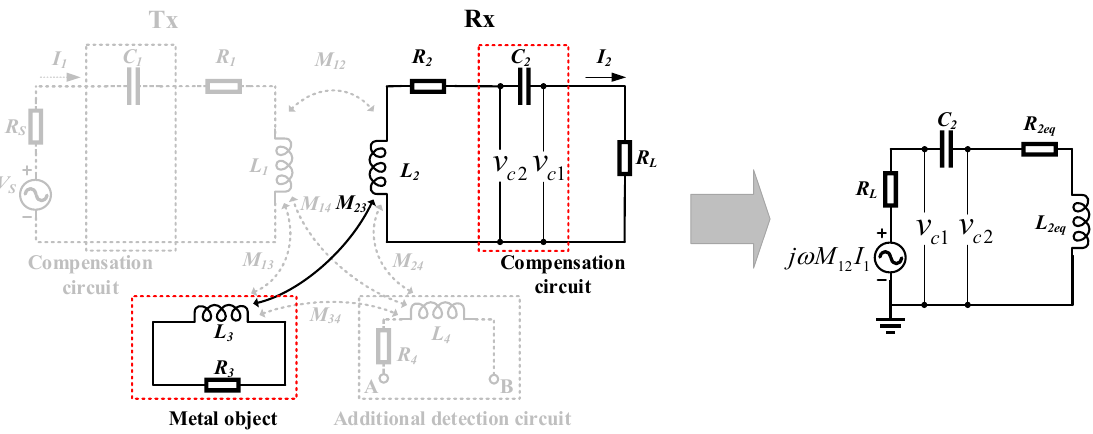
Figure 8. Equivalent circuit of the receiving-side Q factor detection method.